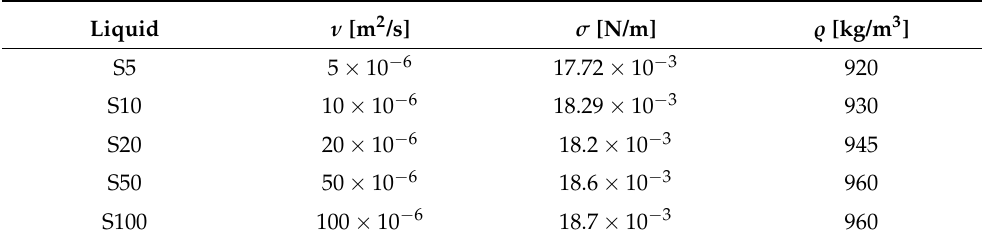
Table 1. Material properties of the liquids used in the experiments: kinematic viscosity ν , surface tension σ and density (cid:36) . The abbreviation “Sxx” denotes silicone oils with different respective viscosity.